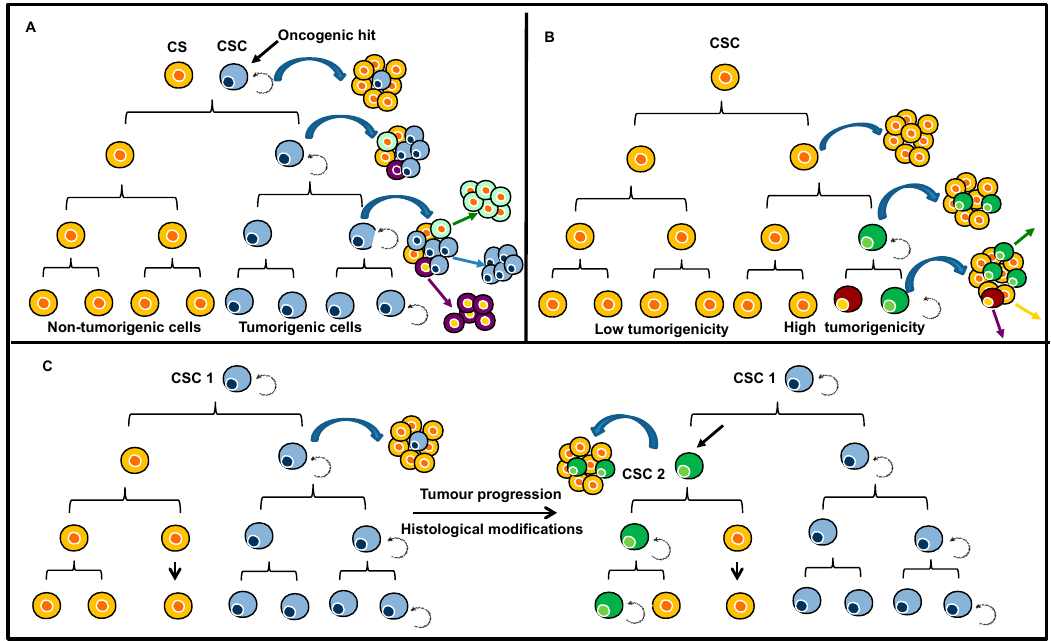
Figure 1. Two models for tumour heterogeneity and propagation: ( A ) In the cancer stem cell (CSC) model, only the CSCs can generate a tumour based on their self-renewal properties and enormous proliferative potential. The tumour heterogeneity is associated with the capacity of differentiation of these CSCs and series of mutations and/or epigenetic events. The other cancer cells (CS) are non tumorigenic in immunodeficient mice for instance; ( B ) In the clonal evolution model, all undifferentiated cells (CSC) have initially similar tumorigenic capacity. However, CSCs acquire a series of mutations resulting in dominant clones; and ( C ) Both tumour maintenance models may underlie tumorigenesis. Initially, tumour growth is driven by a specific CSC (CSC1). With tumour progression, another distinct CSC (CSC2) may arise as a result of clonal evolution in CSC1. This may be a result of the acquisition of an additional mutation or epigenetic modification. CSC2 is more aggressive and becomes dominant, driving tumour formation. (Adapted from Visvader, J.E.; Lindeman,